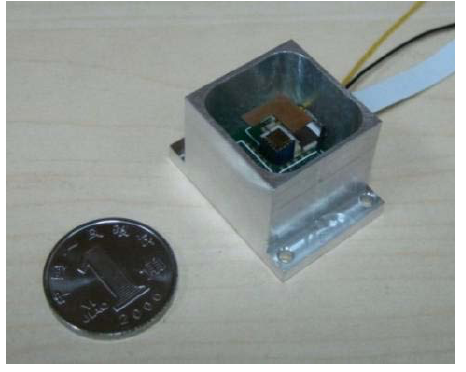
Figure 7. Package of two-dimensional scanning micro-mirror.